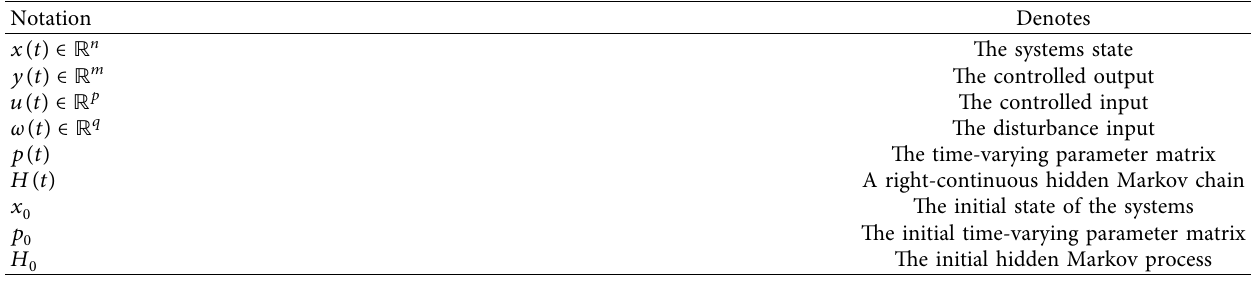
Table 2: The notations of the PV-HMJSs